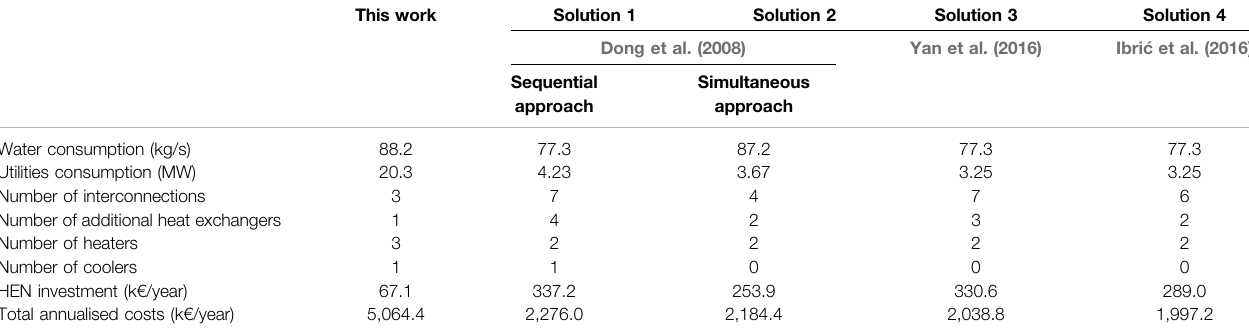
TABLE 19 | Comparison of Key Performance Indicators (KPI) for the same approached